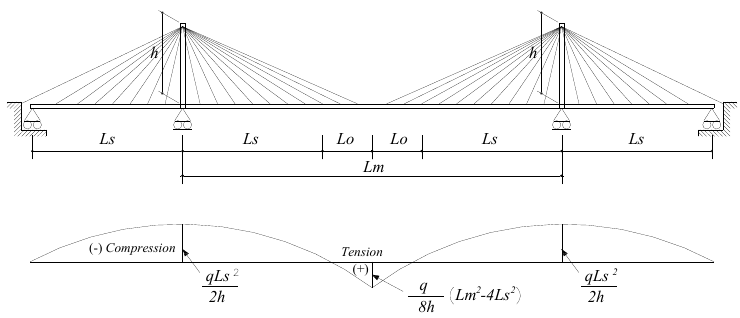
Figure 1. Axial force distribution of a partially earth ‐ anchored cable ‐ stayed bridge.